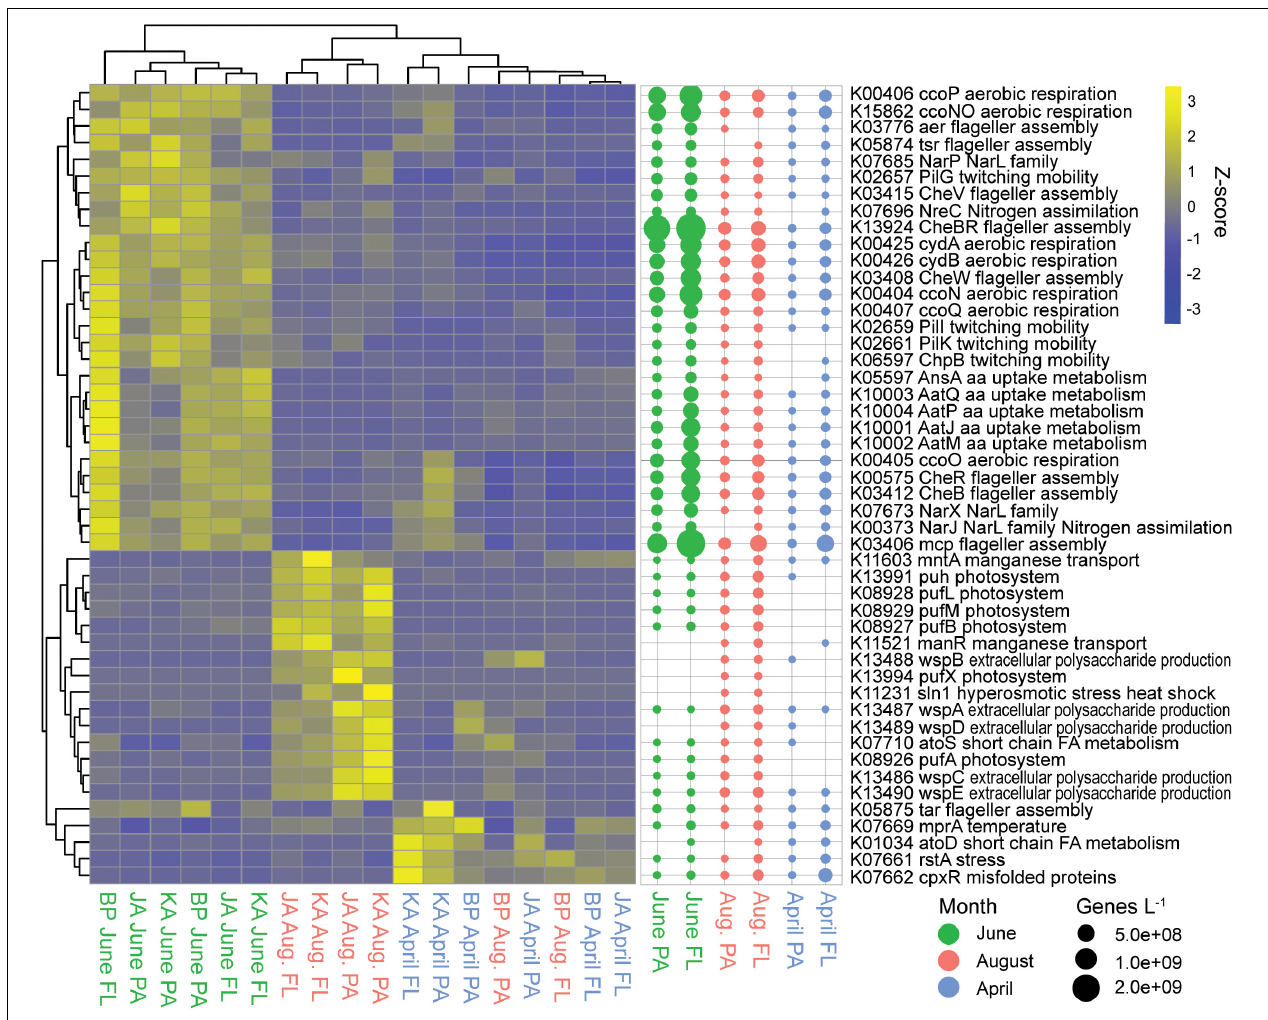
FIGURE 6 | Two-component system indicator genes (KEGG pathway ko02020). Heatmap of z-scaled GPM gene abundances for each sample with yellow being higher abundance and blue lower. Bubble plot of genes/L abundance for each month and size-fraction